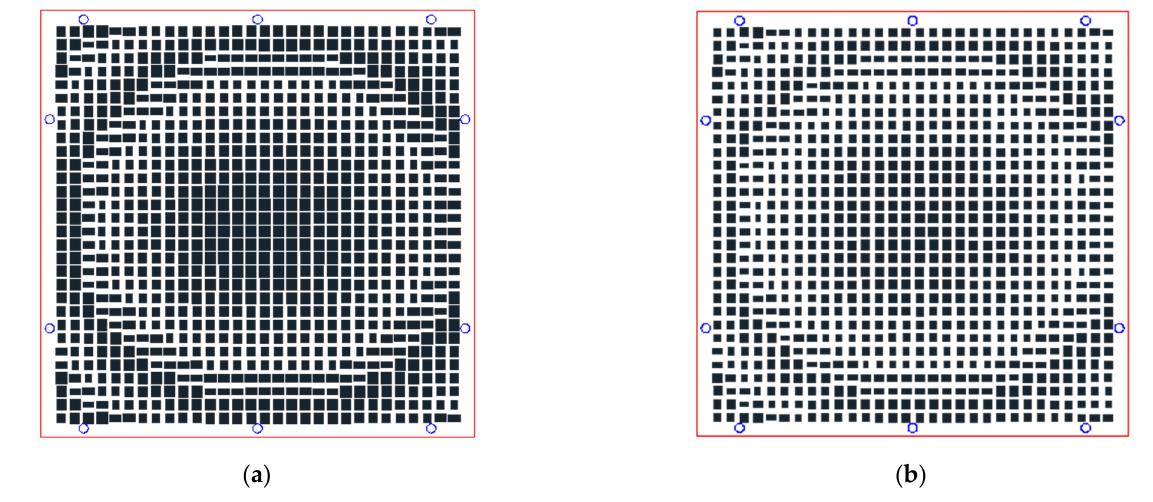
Figure 6. Photo-etching masks of the designed reflectarray antenna, corresponding to the ( a ) lower layer and ( b ) upper layer of rectangular patches.